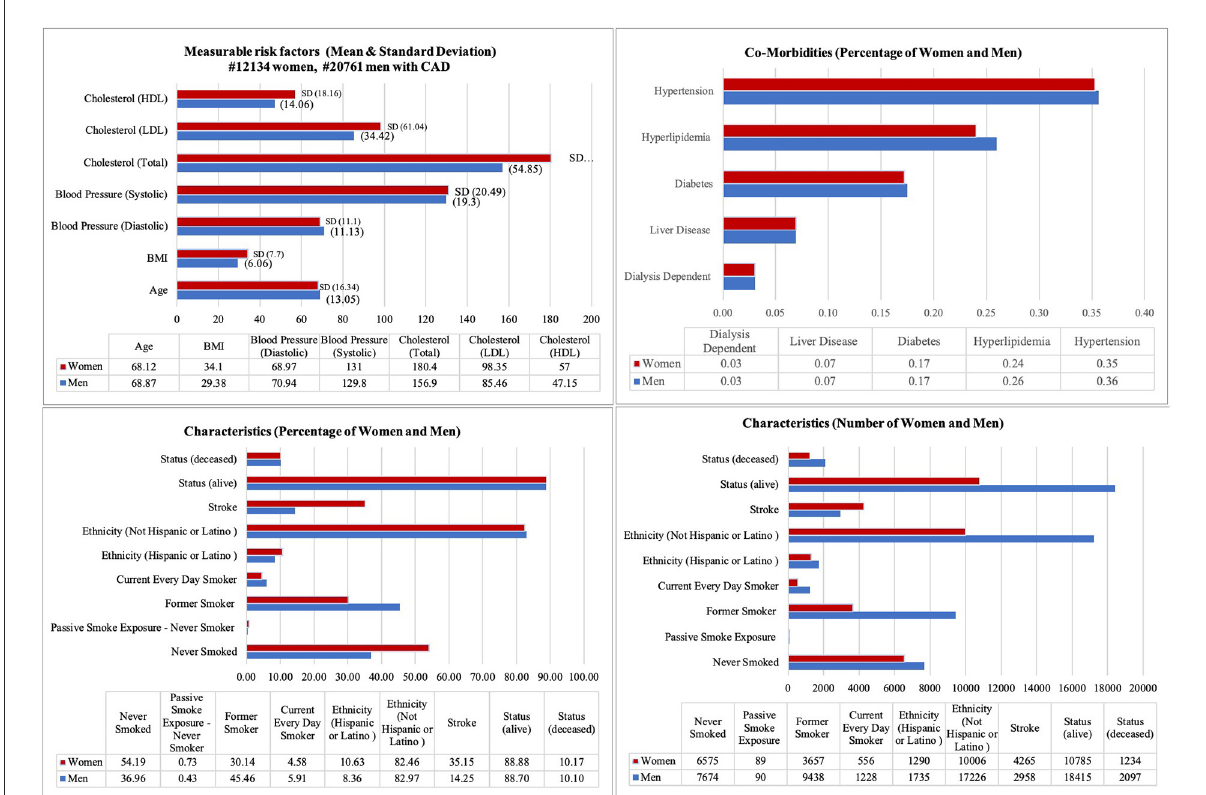
FIGURE3 Vital, demographic characteristics and co-morbidities for patients with CAD. It illustrates the mean and standard deviation (SD) for measurable risk factors (e.g., Cholesterol, Blood Pressure, BMI, and Age), Characteristics percentage and number for both gender (e.g., Status, Ethnicity), and Comorbidities [e.g., Hypertension (ICD10 code I10-I15), Dialysis (Z99.2), Diabetes (E08-E13), and Hyperlipidemia